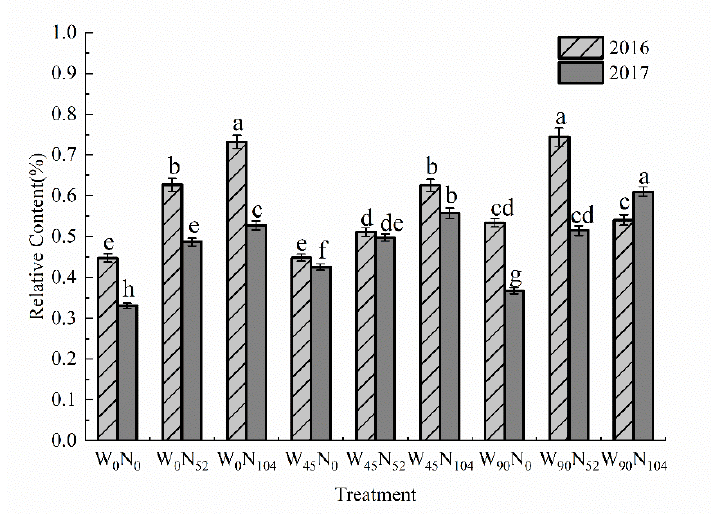
Figure 9. Influence of irrigation and nitrogen and the interaction between the two on ammonia content of sunflower seed kernels (mean ± SD; different lowercase letters indicate that there are significant differences in nine treatments at the 5% level in 2016 and 2017,respectively).